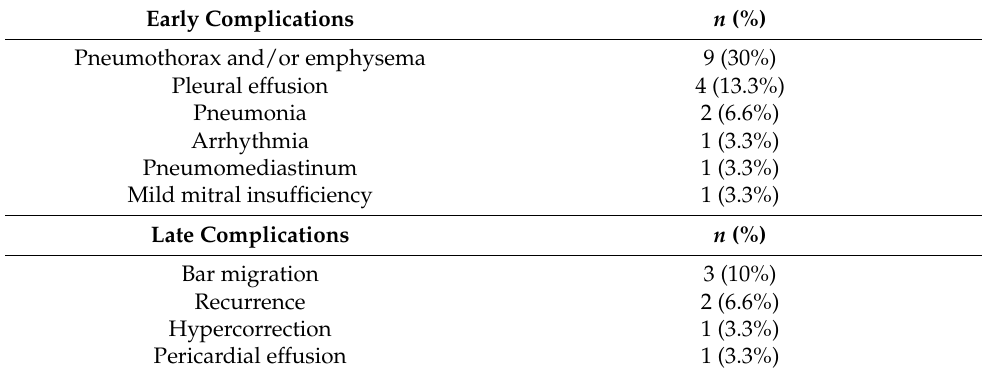
Table 3. Early and late postoperative complications after Nuss procedure.